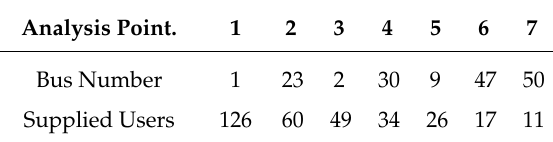
Table 1. Overview of analysis points. Analysis Point.